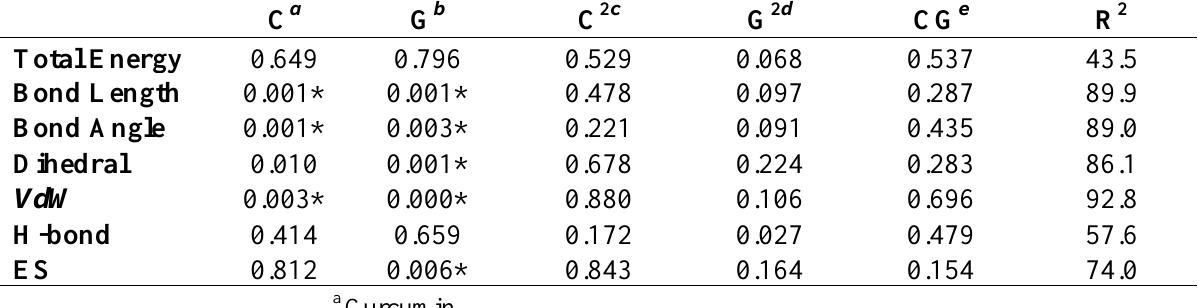
Table 9. Pertinent statistical descriptors for determining the model adequacy ( p-values and R 2 ).